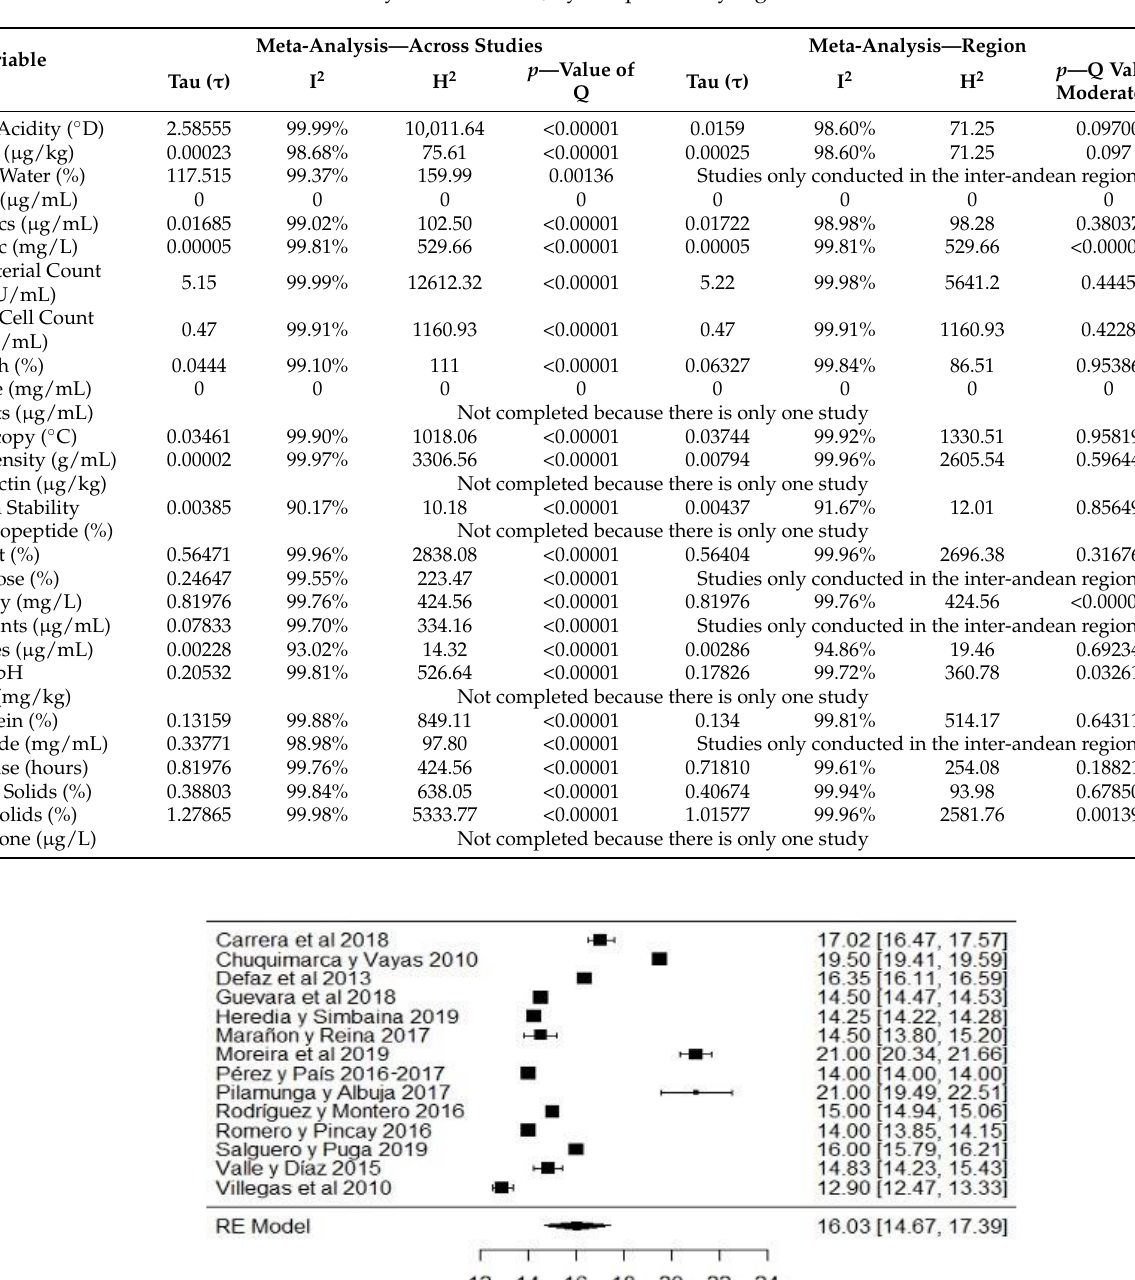
Table 2. Meta-analysis of variables, by sample and by region.